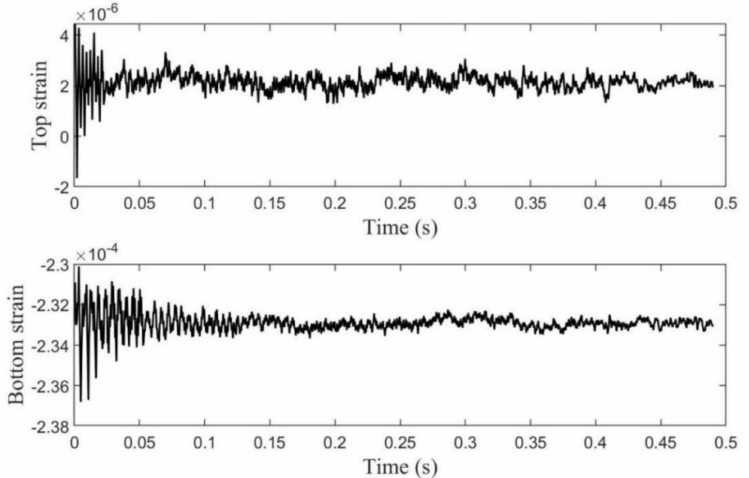
Figure 14. The strain responses calculated from the FEM at the locations of II_t and II_b.